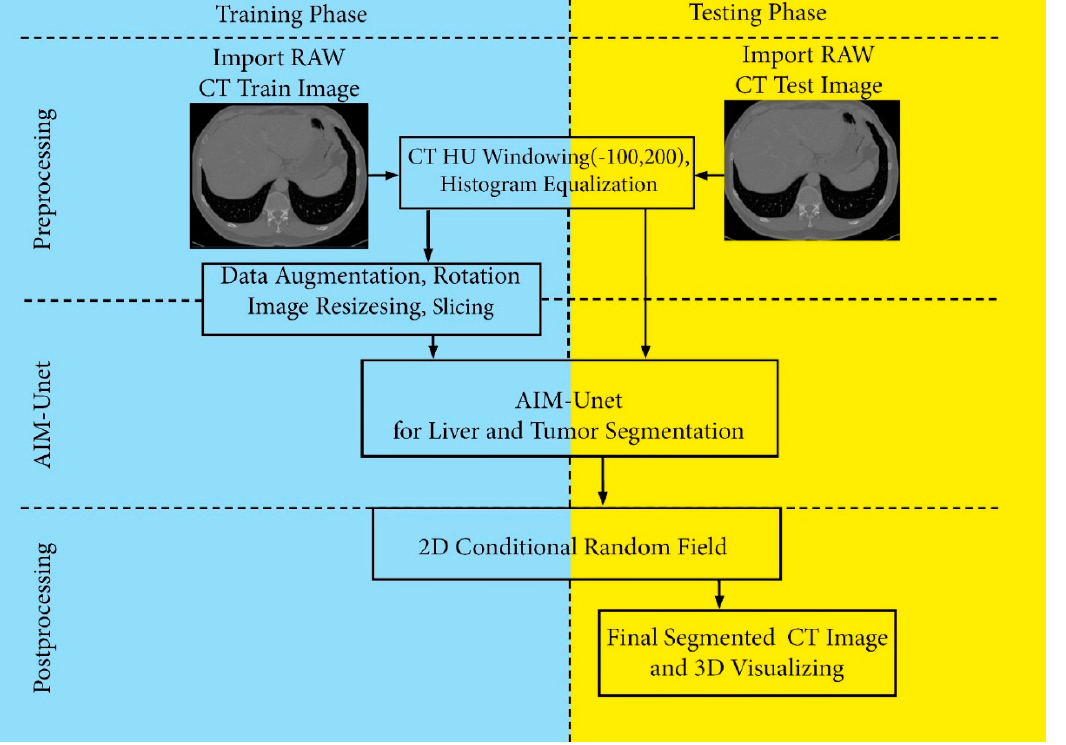
Figure 1. The schematic representation of the AIM-Unet model .